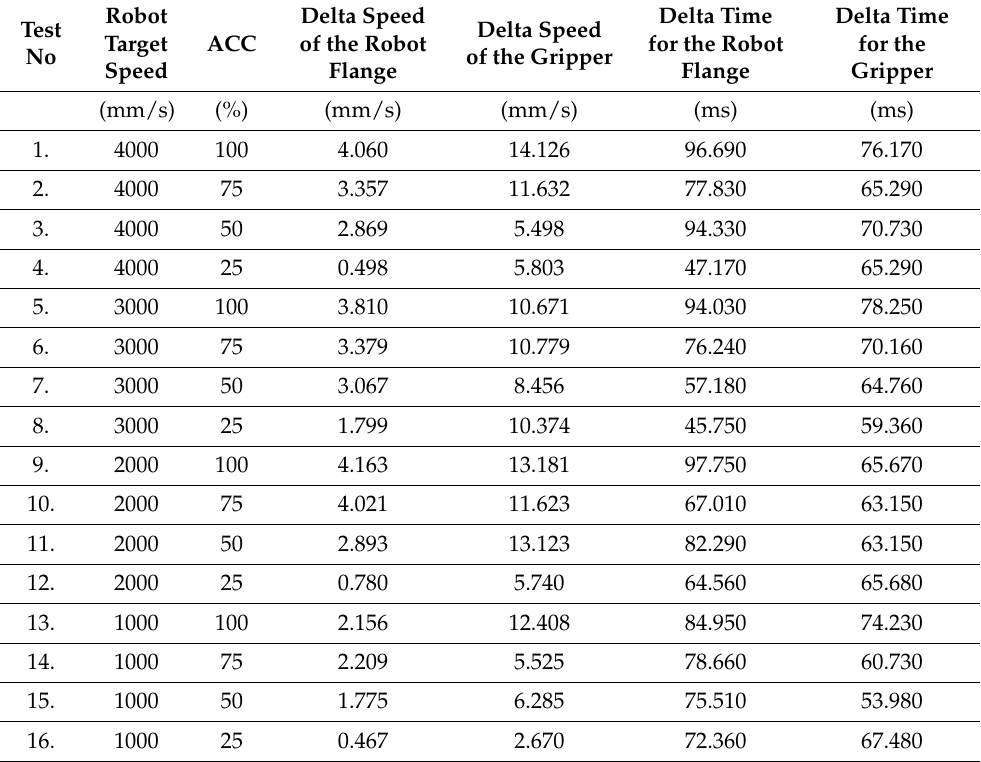
Table 3. Summary of peak values for the tests performed.